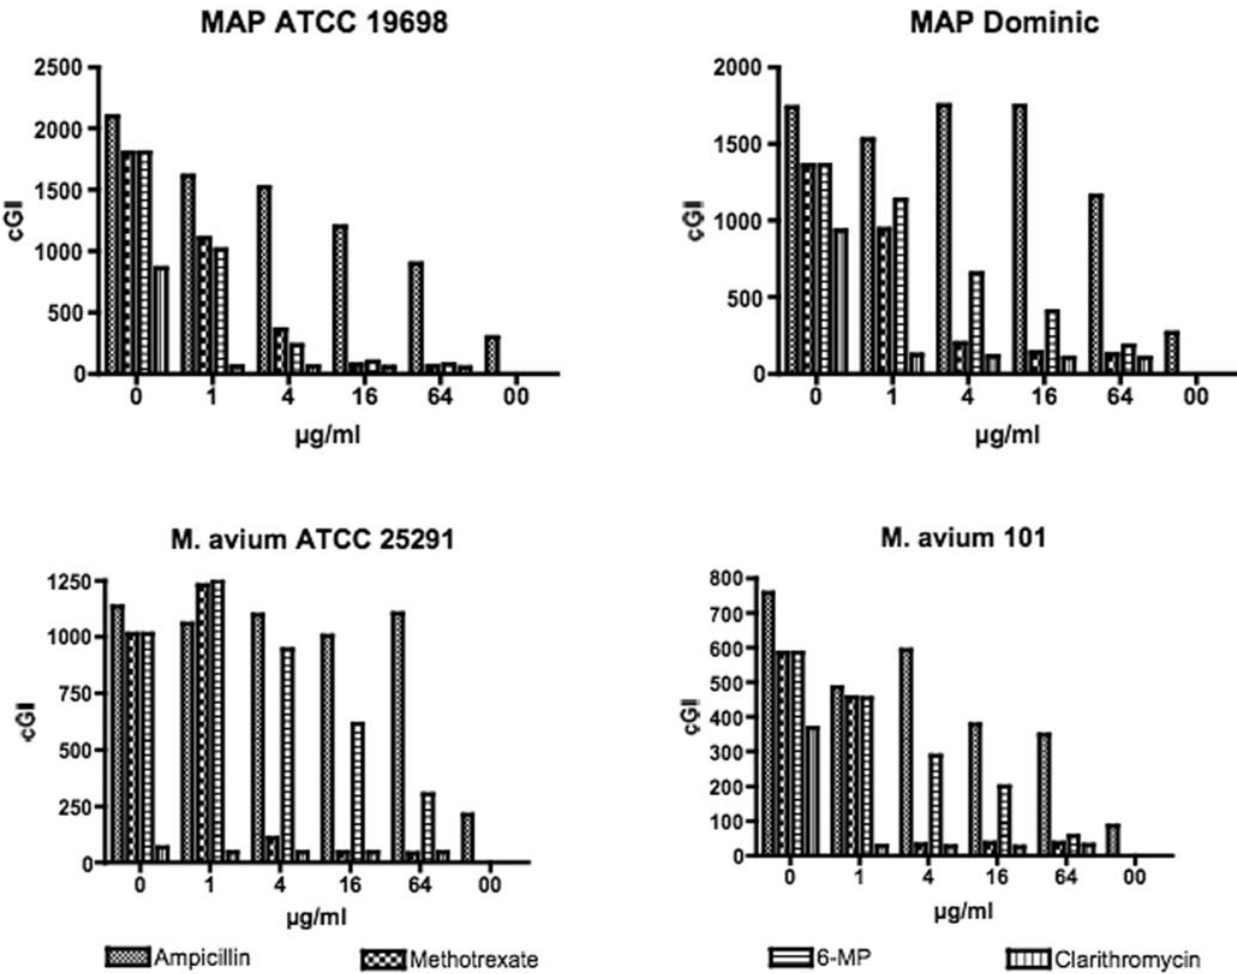
Figure 2. A composite graph of the four bacterial strains studied. ‘‘0’’ is diluent control with an equal CFU inoculum and ‘‘00’’ is a 1:10 dilution of the water control inoculum. Drug concentrations are indicated on the abscissa. For each isolate, drug dose was studied in singlicate. For all four bacteria, clarithromycin has achieved maximal inhibition by 1 m g/ml. For MAP ATCC 19698, replicating data presented in Figure 1, both methotrexate and 6-MP % 2 D GI is the same as for clarithromycin by 4 m g/ml. Note that with the other MAP isolate (Dominic) and both M. avium isolates, methotrexate is more effective at a lower dose than is 6-MP. The lower cumulative GI (seen on the ordinate) for the M. avium isolates is ascribable to their more rapid growth and earlier reaching the off scale BACTEC GI values of